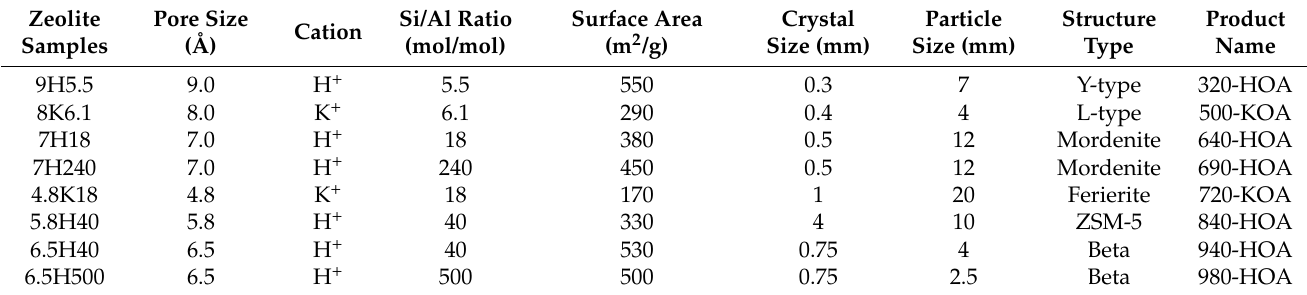
Table 1. The structure and composition of the eight types of zeolite used in this report.